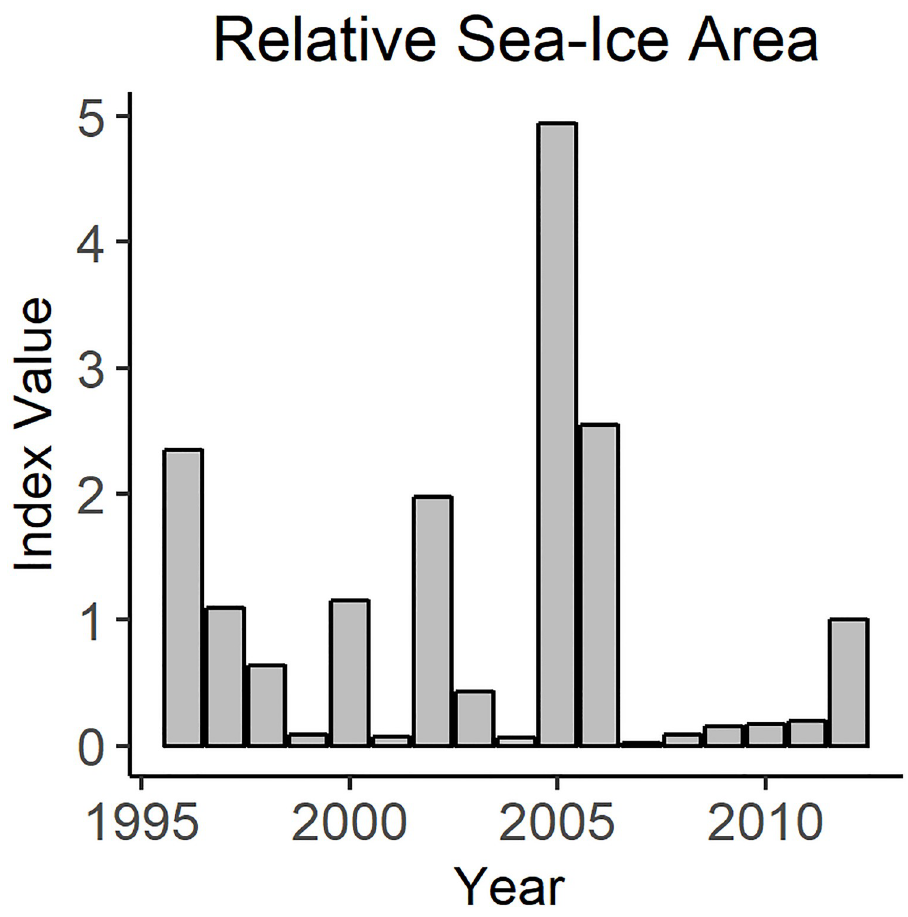
Fig 2. Annual sea-ice index